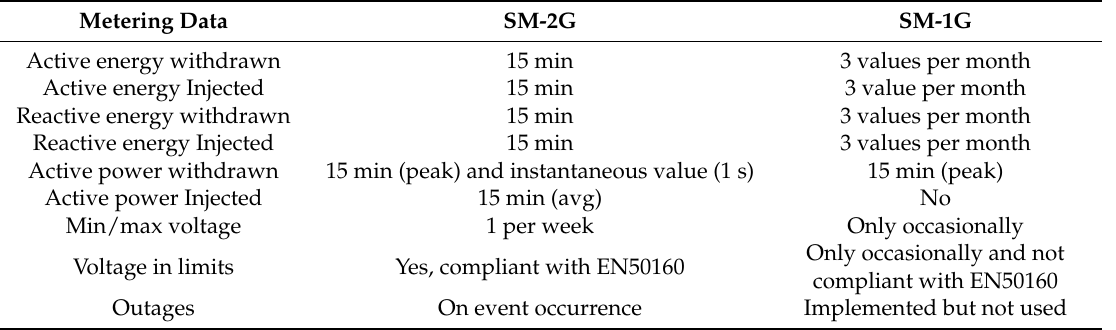
Table 1. Second generation Smart Meter (SM-2G) data comparison with respect to the first generation (SM-1G).